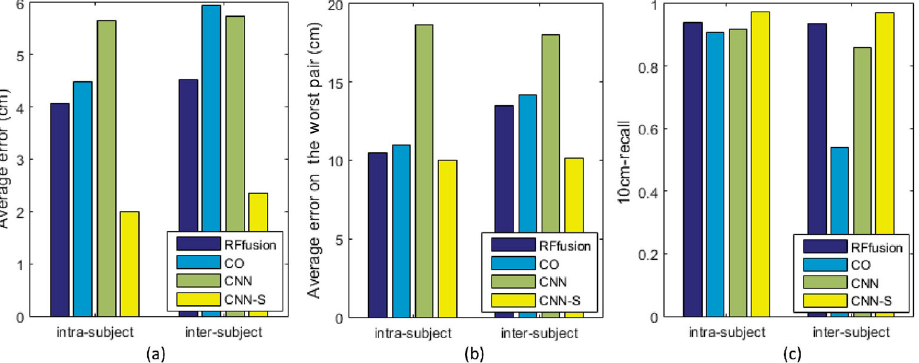
Fig. 10 Comparison in terms of (a) average error, (b) average error on the worst pair, (c) 10 cm recall for the proposed method, CO [51], CNN [52], and CNN-S [52] on the Faust